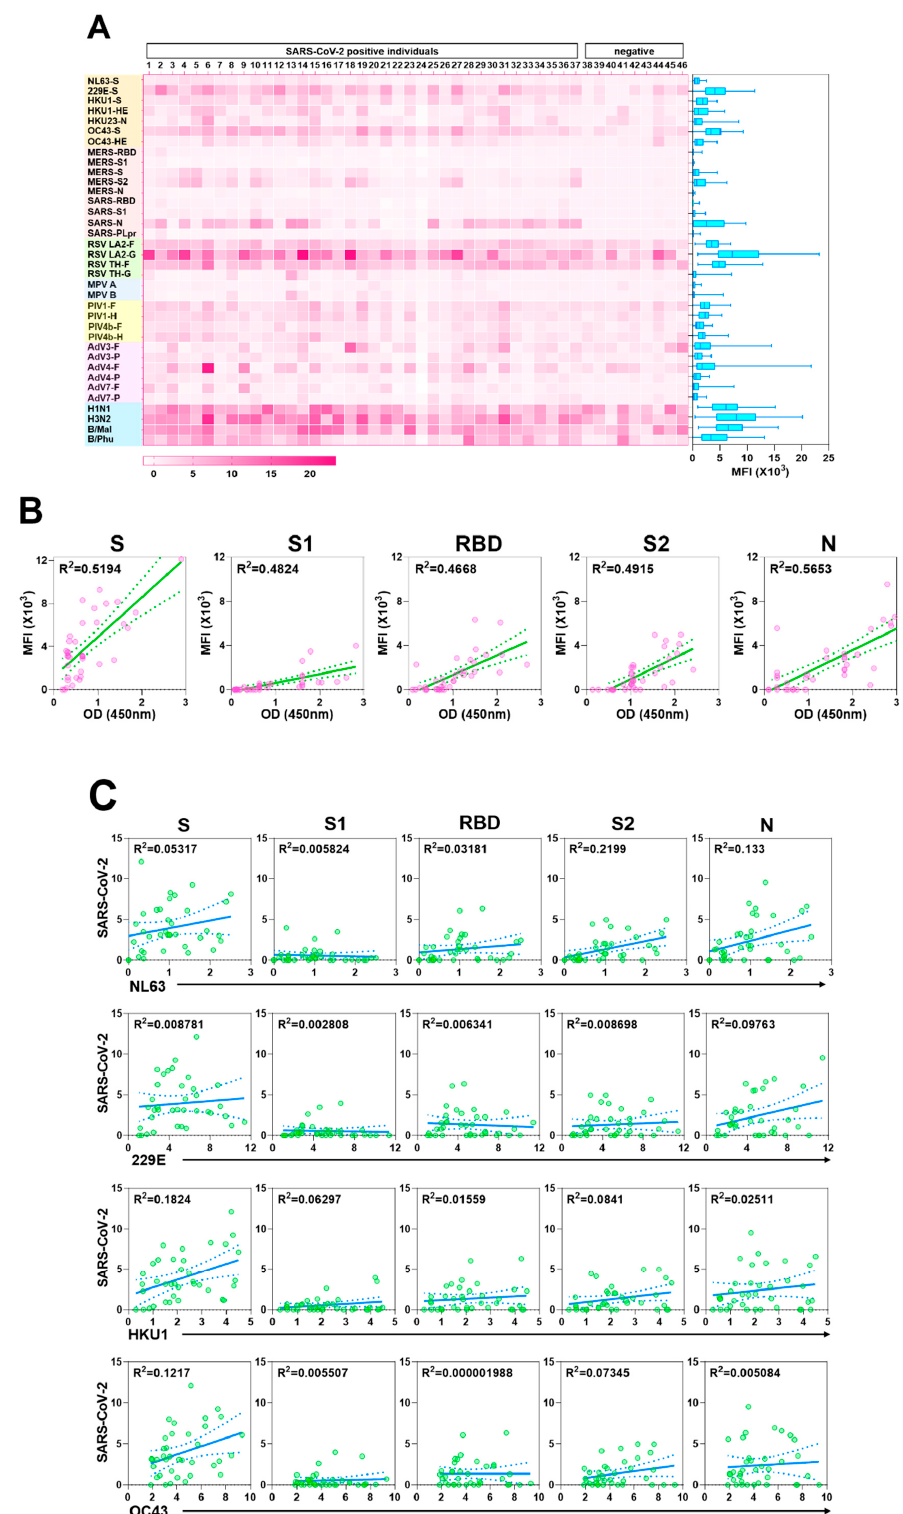
Figure 2. Preexisting and cross ‐ reactive antibodies to human respiratory viruses in sera of patients with COVID ‐ 19. ( A ) Respiratory virus ‐ specific antibody profiling. Heatmap indicating IgG antibody responses in 46 sera samples (37 COVID ‐ 19 samples and 9 control samples) measured by protein microarray. The microarray slides were probed with human sera and labeled with secondary antibodies to human IgG conjugated to a quantum dot fluorophore. The slides were imaged using the GenePix 4000B Microarray Scanner to measure background ‐ subtracted median spot fluorescence. Mean fluorescence intensity (MFI) of the 4 replicates for each antigen was used for analysis. Each column represents a paired sample, and each row, a respiratory virus protein. Box graph indicates the sum of antibody responses of all sera samples for each respiratory virus protein. ( B ) Correlation between protein microarray and ELISA ‐ based readouts. Each dot indicates the antibody response of serum from a single patient with COVID ‐ 19 against S, S1, RBD, S2, and N of SARS ‐ CoV ‐ 2, as measured by fluorescence intensity (y ‐ axis) and absorbance at 450 nm, as determined by ELISA (x ‐ axis). ( C ) Relations of antibody response between specific antibody levels against SARS ‐ CoV ‐ 2 and those against endemic HCoVs NL63, 229E, HKU1, and OC43 in patients with COVID ‐ 19.